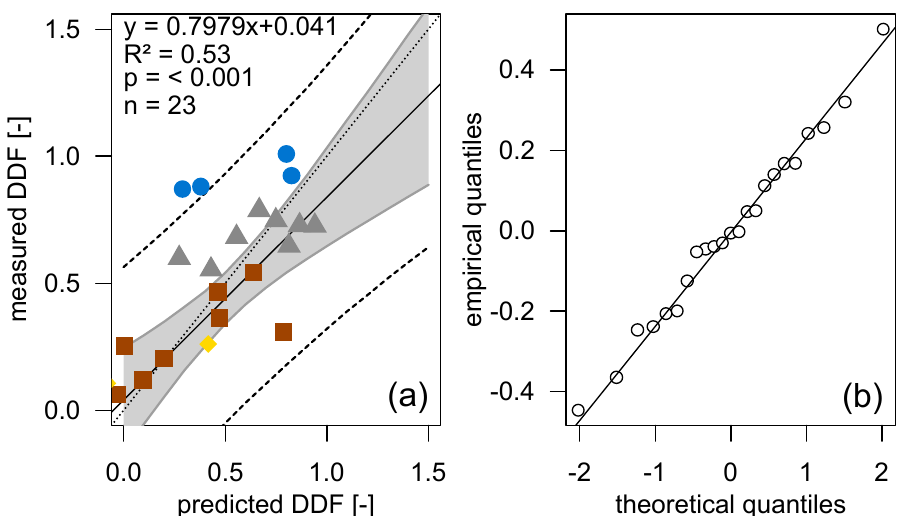
Figure A1. Relationship between predicted and measured dry deposition factors (DDF) for forest stands from two different age chronosequence studies in Germany [161,162] used for model evalu- ation. ● : Norway spruce and Douglas fir, ■ : European beech, ▲ : Scots pine, ♦ : Pedunculated/Ses- sile oak ( a ) Normal probability plot (Q-Q plot) for visual assessment of residuals ( b ).